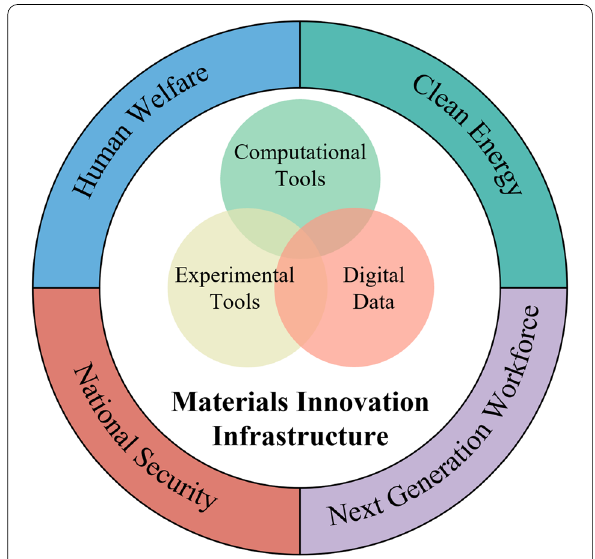
Fig. 1 Overview of the Material Genome Initiative (MGI) in the United States